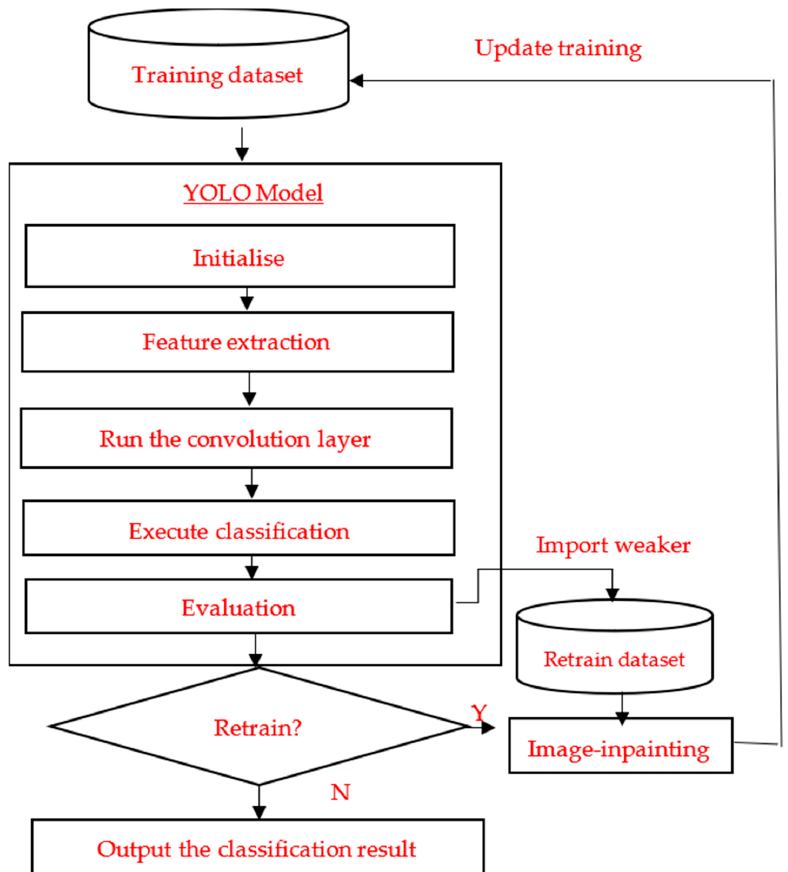
Figure 4. The procedures of the proposed method.